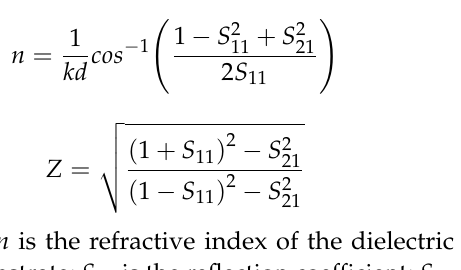
Figure 2. S-parameter curves corresponding to different structural parameters ( a ) When a is a different value ( b ) When w is a different value.